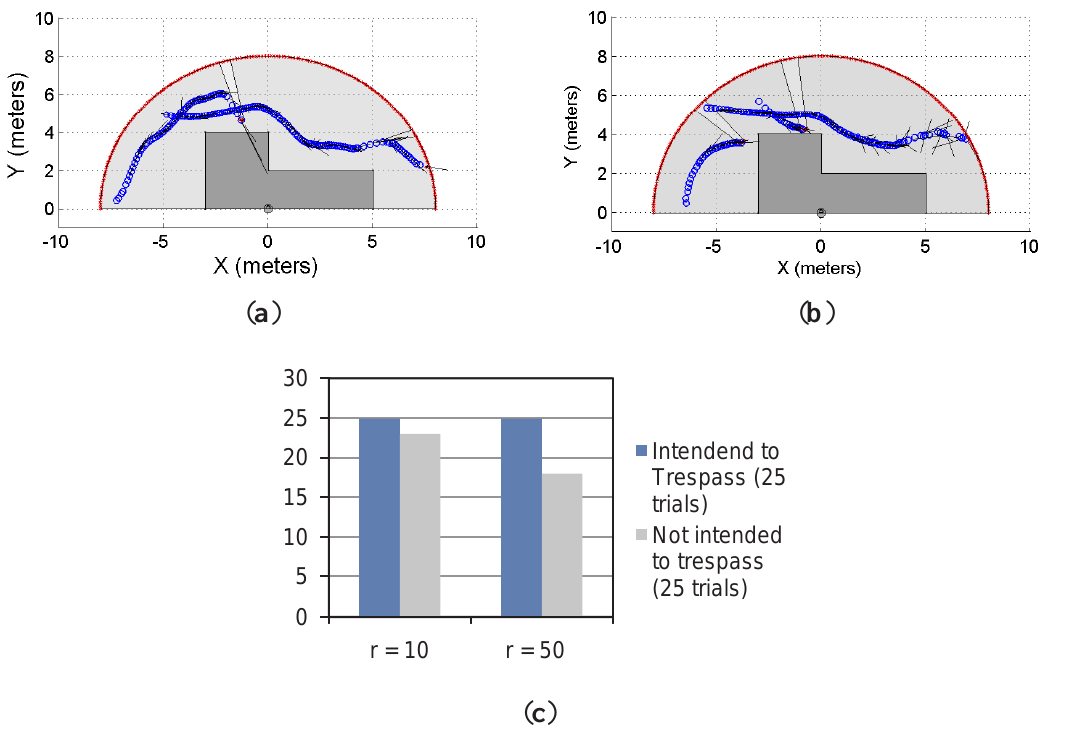
Figure 8. Second approach of the multi-object detection using a single laser